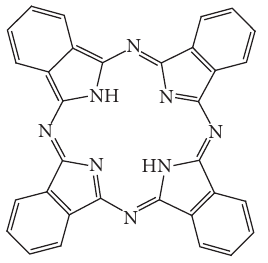
Scheme 1: Structure of phthalocyanine (Pc).